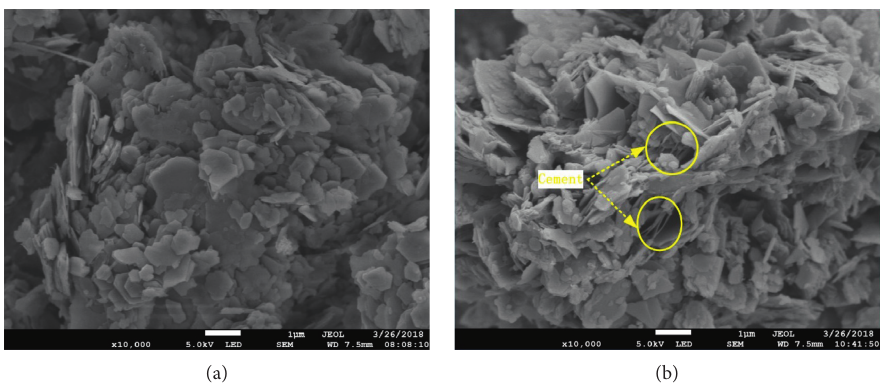
Figure 7: SEM images of (a) lime-kaolinite and (b) lime-metakaolin.